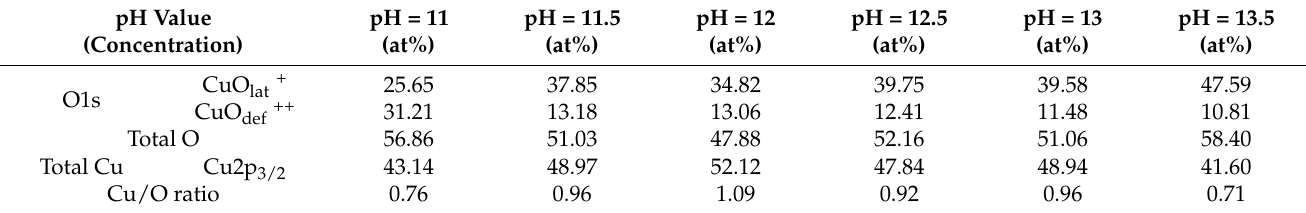
Table 1. Concentration (at%) of O1s and Cu2p 3/2 of the MWCBD-CuO films obtained at different pH